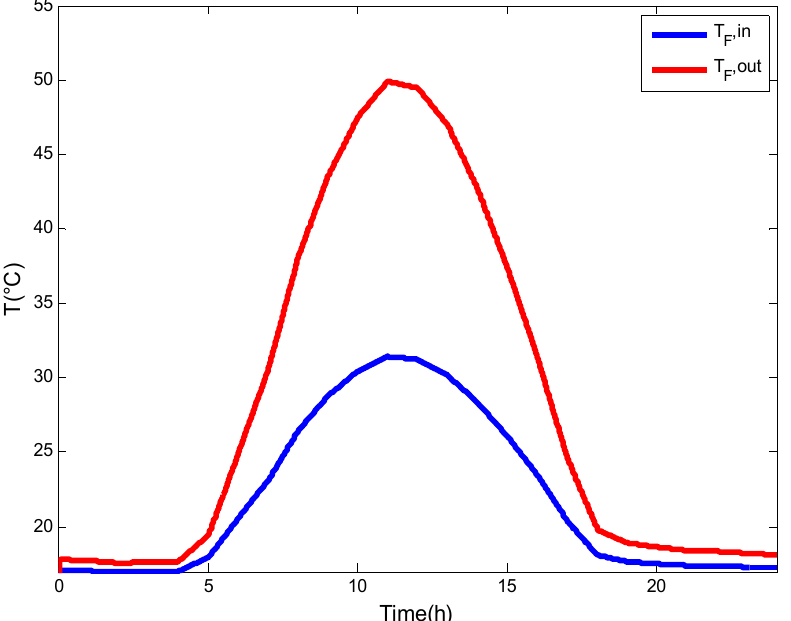
Figure 10. Variation of the inlet and outlet of the heat transfer fluid temperatures from the flat plate collector with time.